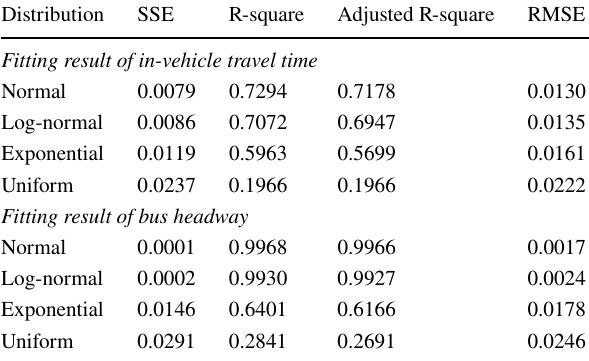
Table 1 The fitting results of three